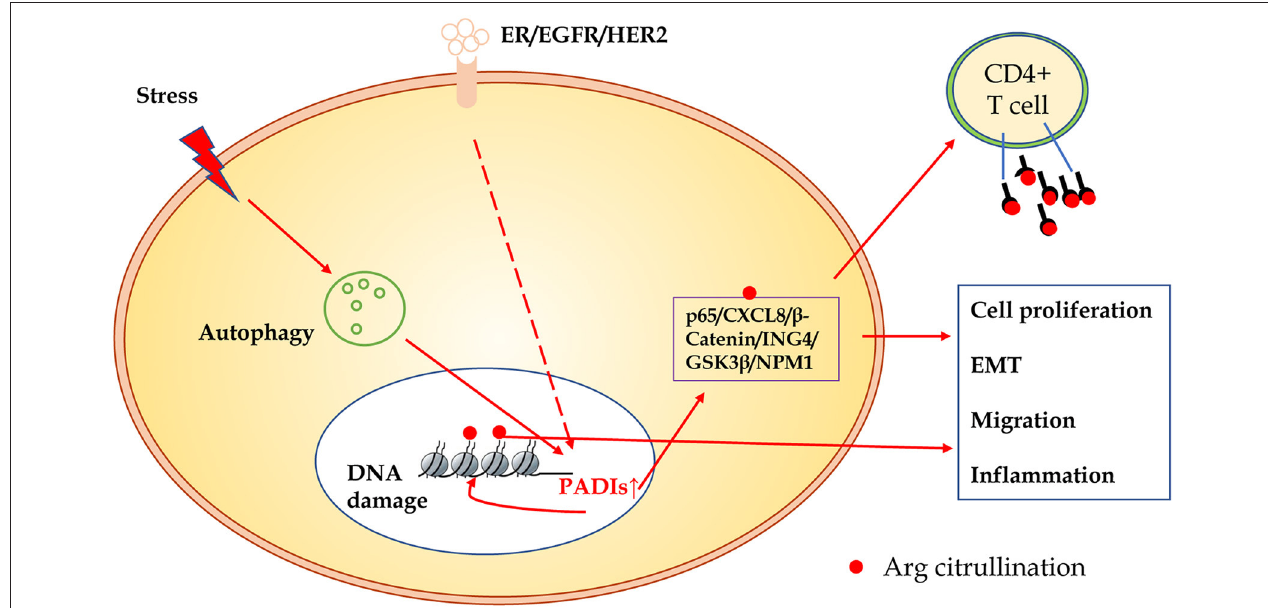
FIGURE 3 | The schematic presentation of citrullinated modification of proteins and its biological significance. PADIs enzymes are activated through receptors of ER/EGFR/HER2, oxidative stress, hypoxia, and other microenvironment factors, which initiate autophagy and DNA damage. Increased PADIs catalyze citrullination modification of histones and non-histone proteins, and result in cell proliferation, epithelial-mesenchymal transition, migration, and inflammation. Citrullinated proteins as a new antigen may activate immune response of T cells or induce specific antibodies.